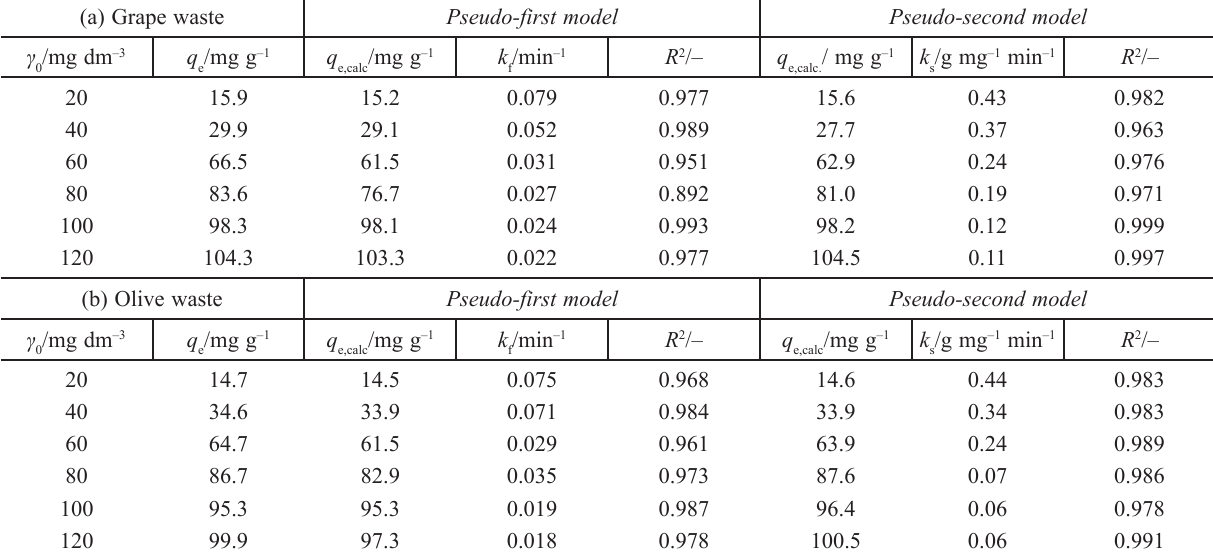
Table 3 – Characteristic parameters of the different kinetic models estimated by non-linear regression for Cr(VI) adsorption on grape waste (a) and olive waste (b) (a) Grape